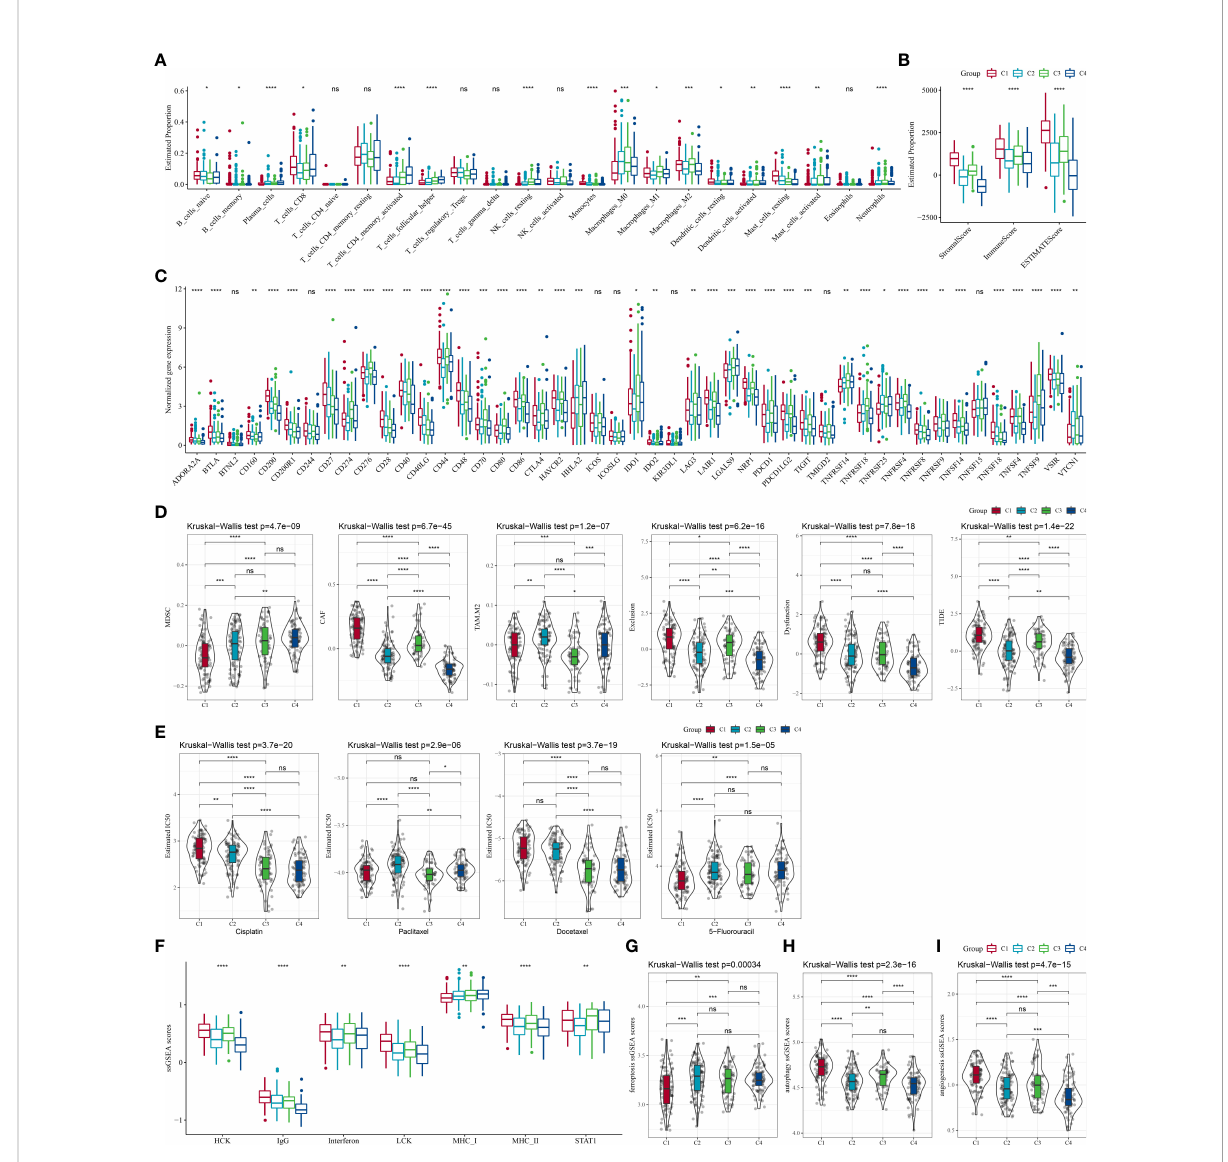
FIGURE 4 The differences in the immune microenvironment and responsiveness to immunotherapy and chemotherapy among molecular subtypes in the TCGA cohort. (A) Estimated proportions of 22 immune cells among the four subtypes; (B) Comparison of the stromal score, immune score, and estimate score in the four subtypes; (C) The expression of immune checkpoints genes in the four subtypes; (D) Differences in TIDE analysis results between different subtypes; (E) The box plots of the estimated IC 50 for cisplatin, paclitaxel, docetaxel and 5- fl uorouracil in